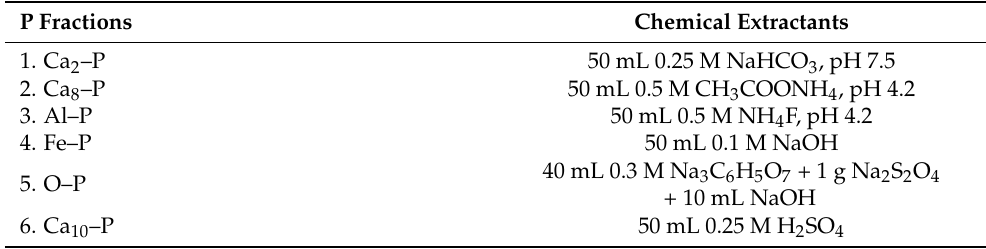
Table 2. Sequential inorganic P fractionation and corresponding chemical